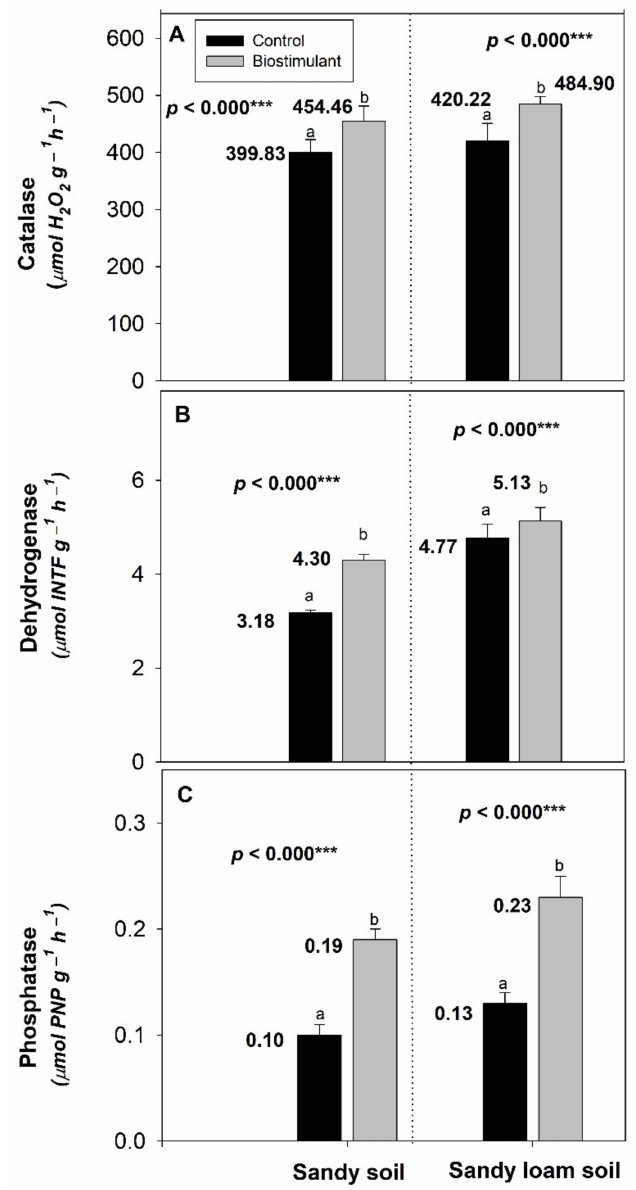
Figure 2. Mean values of catalase ( A ), dehydrogenase ( B ), and phosphatase ( C ) enzymatic activities of soil samples treated by biostimulant and control from the two type of soils. Means followed by different letters are significantly different ( p < 0.05) according to Tukey’s HSD test. Significance levels: *** p <